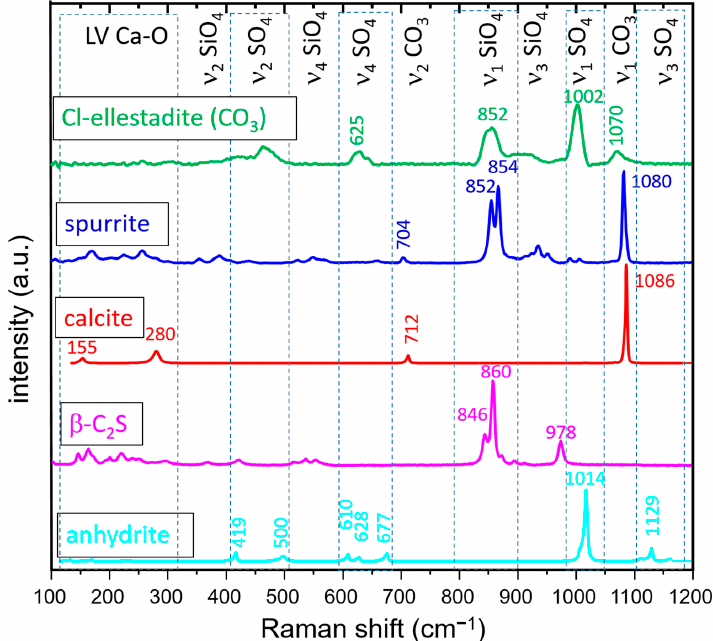
Figure 9. Basis Raman spectra used for Raman imaging of HT[D2]_800. From top to bottom: ellesta- dite, spurrite, calcite, β -C 2 S, anhydrite. In all mixed or pure spectra of ellestadite synthesized at low temperatures, the band at 1070 cm − 1 is present. Therefore, the band at 1070 cm − 1 could be assigned to CO 3 incor- porated in the ellestadite structure. The observations in the literature point to a frequency of 1078 cm − 1 for carbonate in ellestadite [23], but the authors give a spectral resolution of 7 cm − 1 , whereas our spectra were taken with a resolution of <1 cm − 1 . A comparison of the ellestadite spectra of samples treated at 800 °C with those available in the literature or